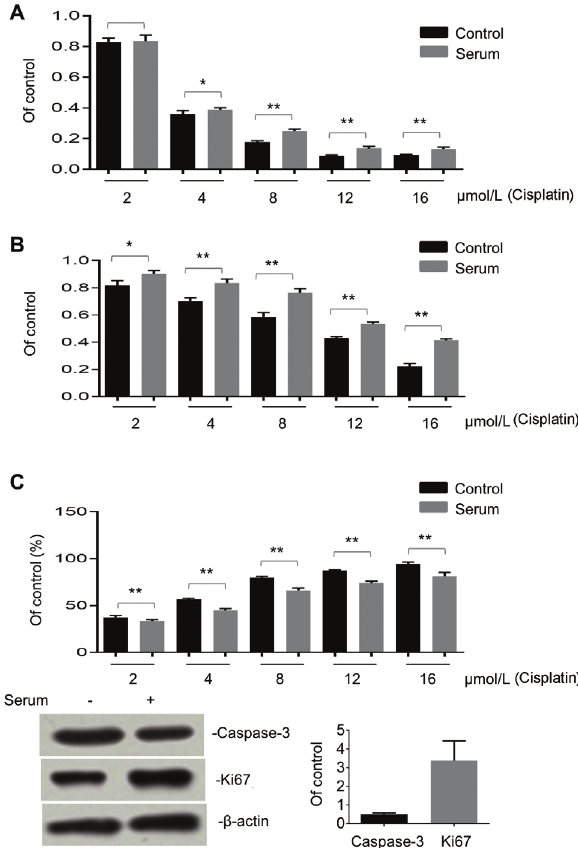
Fig. 5. Proinflammatory factors promoted the invasion and proliferation and reduced the apoptosis rate of A549. The A549 cells were cultured the supernatant of SK-MES-1 for 48 h and also with the treatment of cisplatin (2, 4, 8, 12, and 16 μmol/L) and were placed on plates. The viability of cells (A), invasion capacity (B), and the apoptosis rate (C) were determined ( P <